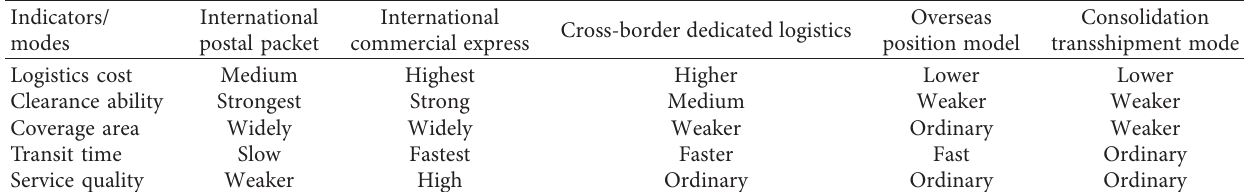
Table 1: Comparison of five export logistics modes of cross-border